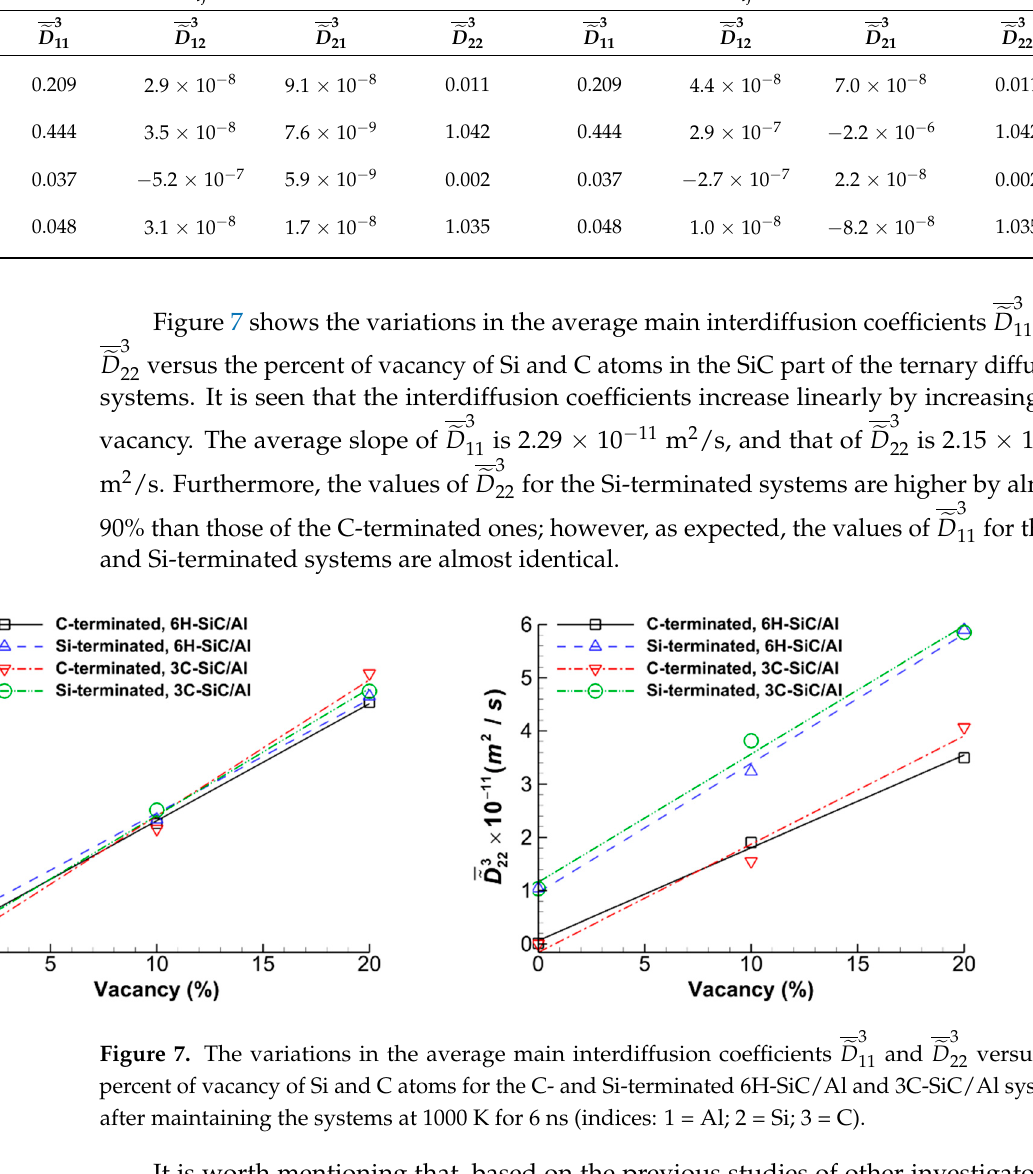
Figure 7. The variations in the average main interdiffusion coefficients (cid:101) D percent of vacancy of Si and C atoms for the C- and Si-terminated 6H-SiC/Al and 3C-SiC/Al systems after maintaining the systems at 1000 K for 6 ns (indices: 1 = Al; 2 = Si; 3 = C).